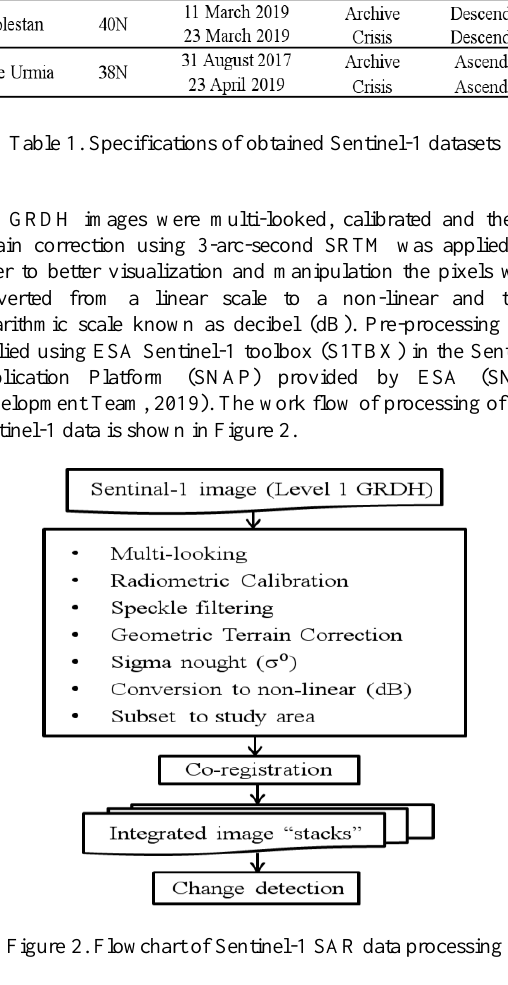
Figure 1. Location maps of the test areas